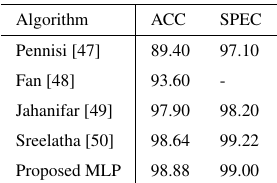
Table 2. The Average performance evaluation metrics